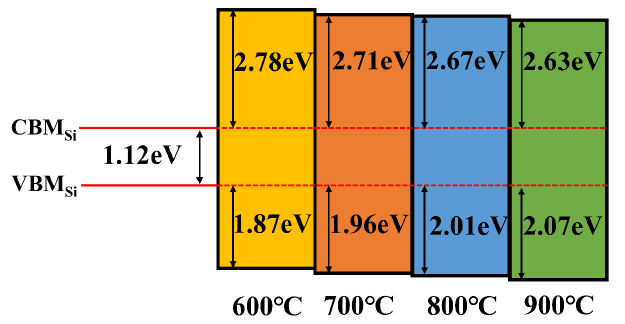
Figure 8. Schematic diagram of the energy bands of AZO films on Si substrate at different annealing temperatures.